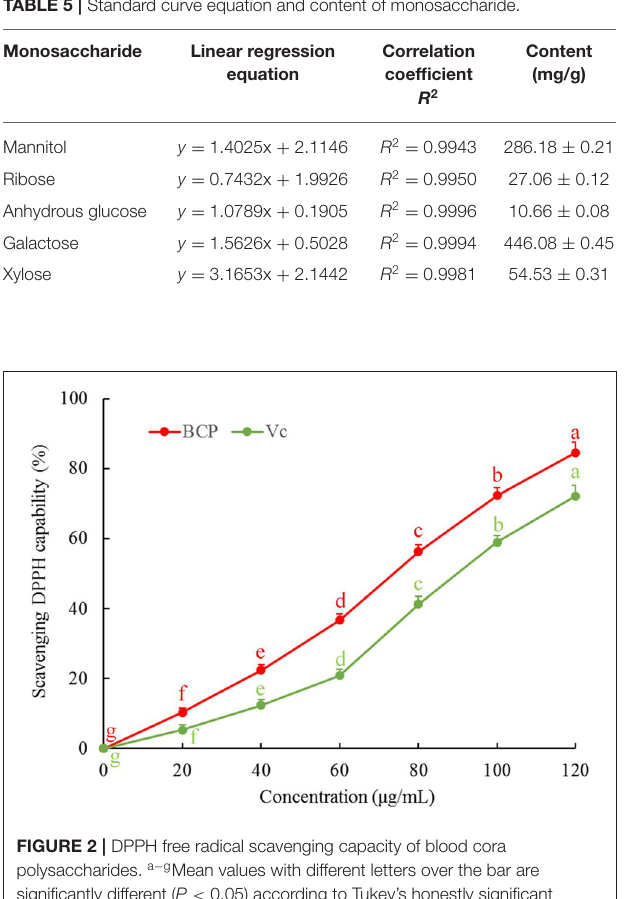
TABLE 5 | Standard curve equation and content of monosaccharide.